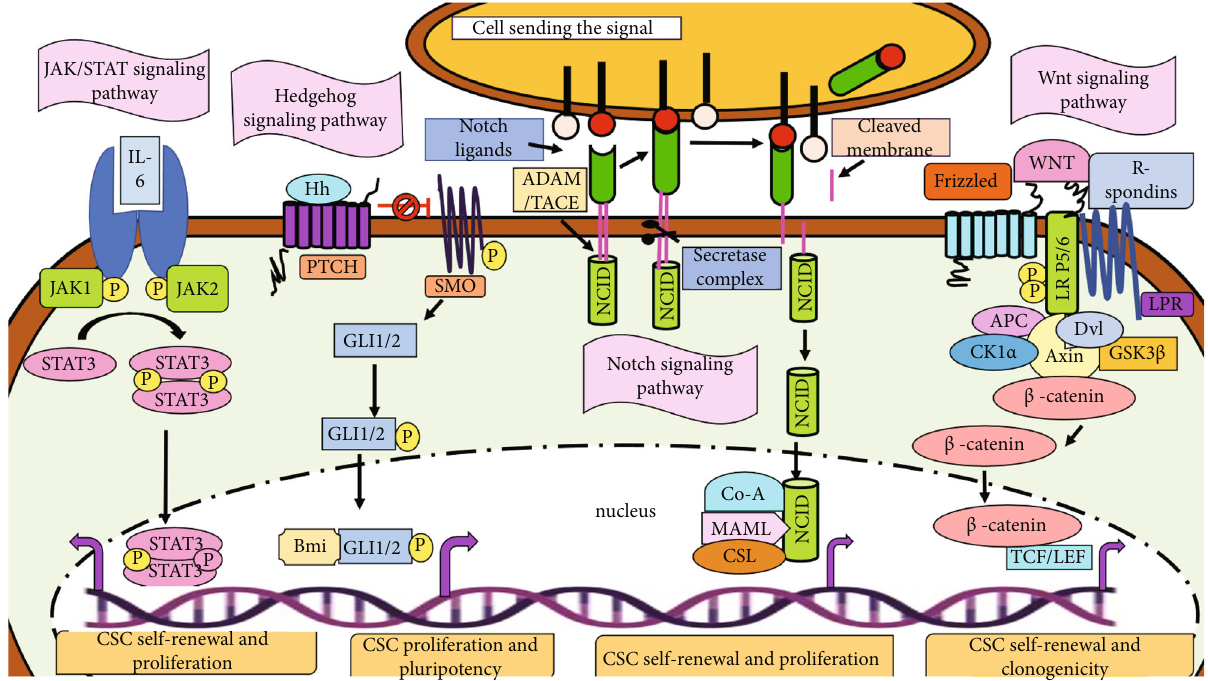
Figure 5: Signaling pathways involved in cancer stem cells. (a) The JAK/STAT pathway (extreme left): JAKs get activated when ligands bind to its receptor; JAK1 and JAK2 auto and transphosphorylate each other and also phosphorylate the tyrosine residues present in the cytoplasmic domain of the receptor. STATs upon phosphorylation by JAKs form dimers and are then translocated into the nucleus to initiate the transcription of the targeted genes. (b) The Hedgehog pathway (left): Hh, when secreted from the other cells, binds to PTCH and allows the activation (indicated by black arrows) of SMO. SMO protein complex secretes Gli1/2 and translocates it into the nucleus, leading to the transcription of Hh-associated genes (depicted by purple arrows). (c) The Notch pathway (right): the binding of the delta ligand to the other cell; two di ff erent enzymes responsible for two di ff erent cleavages are ADAM10 or TACE and a metalloprotease that catalyzes the S2 cleavage and hence producing a substrate for S3 cleavage via the γ -secretase complex. Due to proteolysis, it mediates the release of NCID, which upon translocation into the nucleus starts interacting with the DNA-binding CSL protein and MAML which further activate the transcription process of the targeted genes. (d) The Wnt pathway (extreme right): Wnt ligand binds to Fz, a receptor, and induces the phosphorylation of the coreceptors, LRP5/6, which further forms the docking site for AXIN. The binding of the ligand to the receptor signals Dvl to recruit AXIN 1 along with the other kinases CK1 α and GSK3 β to the membrane, which interrupts the destruction complex leading to impairment of the phosphorylation of β -catenin and results in its destruction. Accumulated β -catenin then translocates from the cytoplasm to the nucleus and functions as an activator of TCF/LEF-mediated transcription of Wnt target